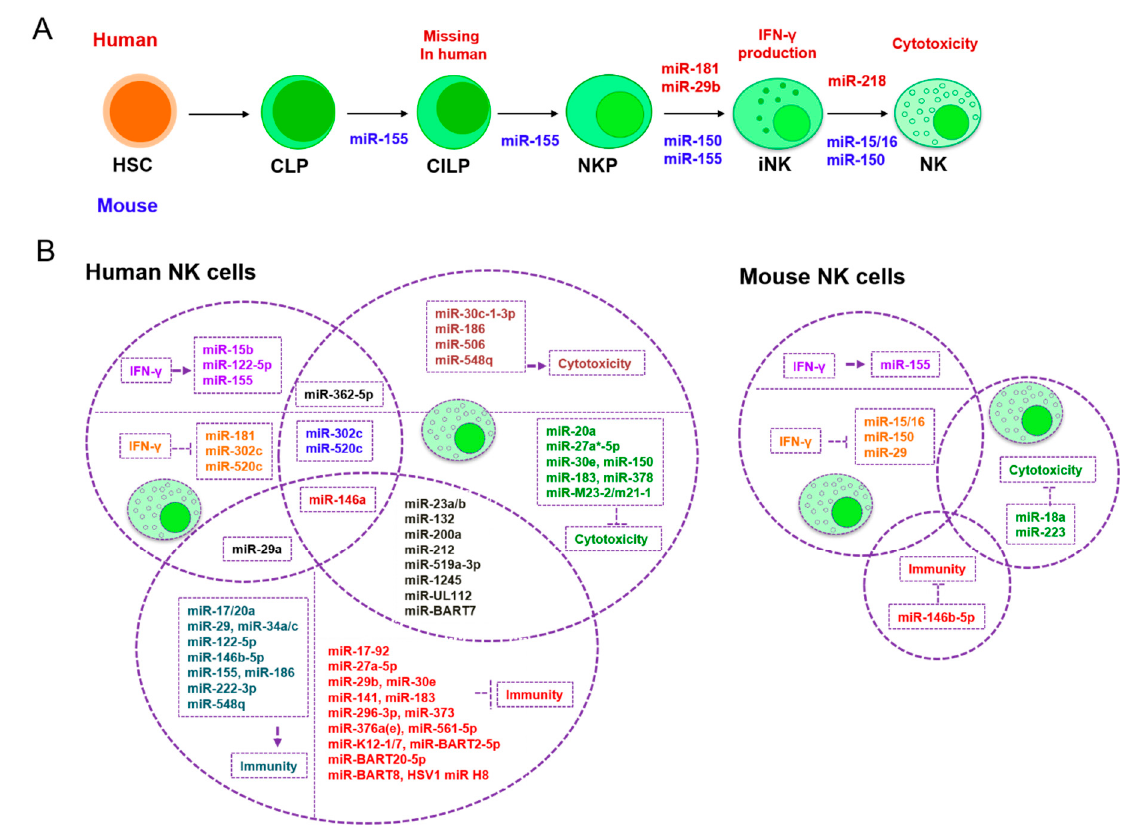
Figure 2. miRNAs involved in NK cell development, NK cell activation, and tumor immunity. ( A ) miRNAs involved in mouse and human NK cell development and maturation. miRNAs listed with arrows regulate each developmental transition of NK cells. Note that human NK cell development, unlike mouse NK cell development, lacks a CILP stage. ( B ) miRNAs involved in IFN- γ production, NK cell cytotoxic capacity, and immune escape in human and mouse systems, respectively. CLP, common lymphoid progenitor; CILP, common innate lymphoid progenitor; NKP, NK-cell precursor; iNK, immature NK; NK, natural killer cell.